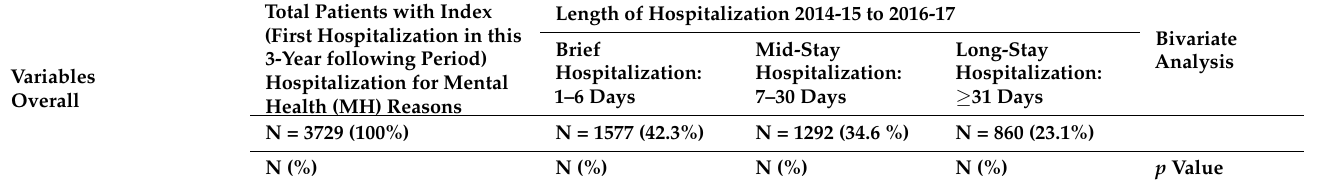
Table 1. Characteristics of patients with mental disorders or substance-related disorders at index (first) hospitalization for mental health reasons from 2014-15 to 2016-17, according to length of